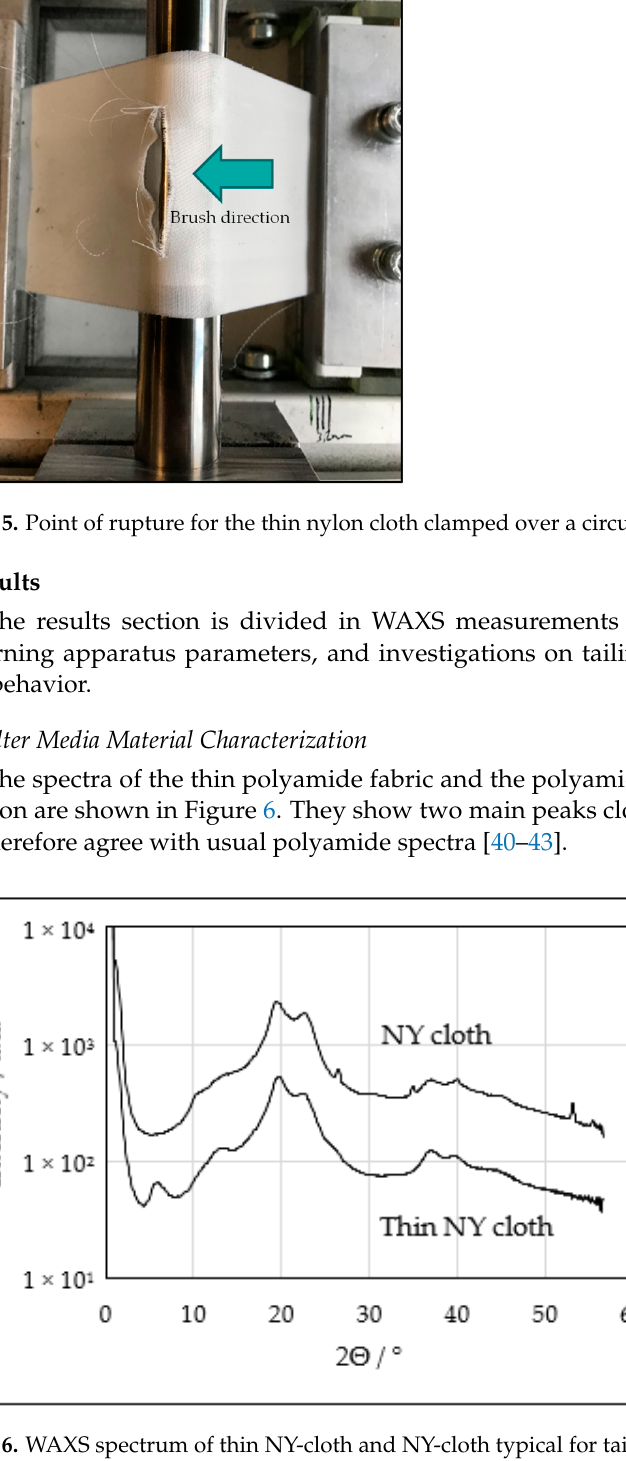
Figure 7. WAXS spectrum of PP-felt and PP-cloth typical for tailings filtration.